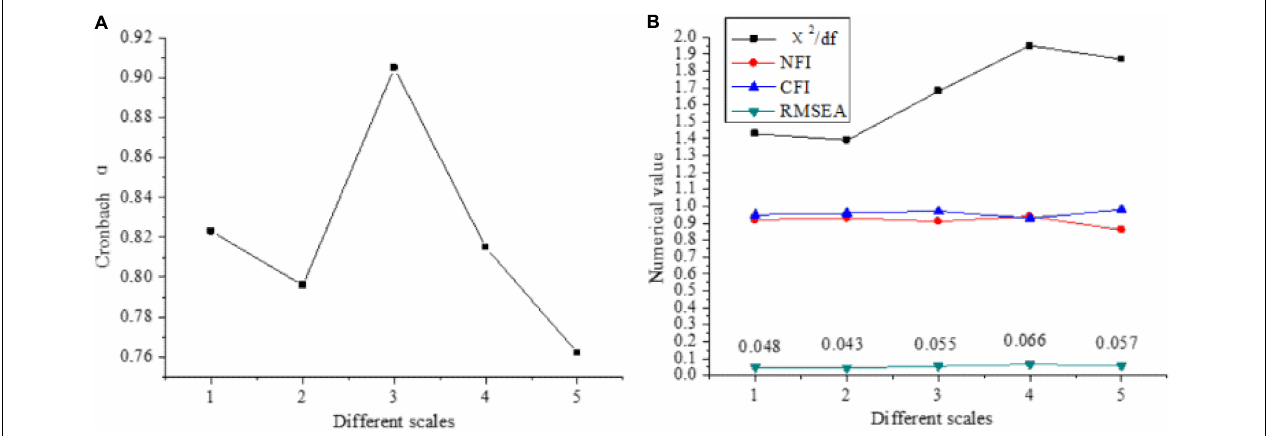
FIGURE 2 | Reliability and validity analysis of the questionnaire [ (A) reliability; (B) validity; 1: success motivation scale; 2: tolerance scale; 3: risk bias scale; 4: control tendency scale; 5: self-confidence scale].